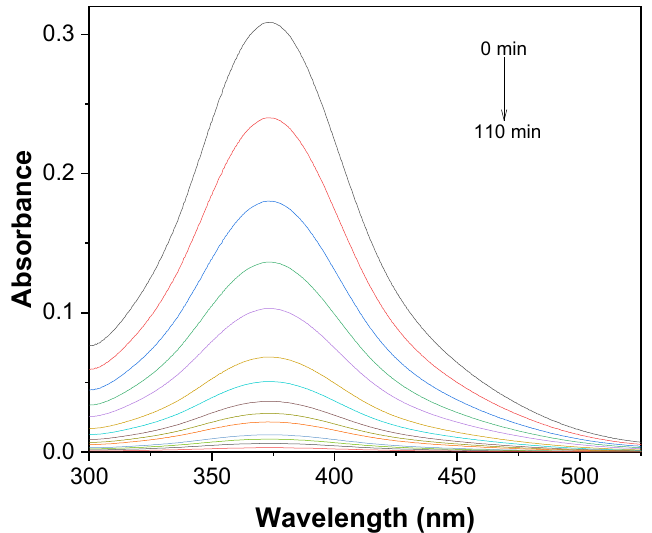
Figure 13. Reduction in the electronic absorption of alizarin yellow R in the presence of CNTs-Ag 2 S under the irradiation to sunlight.